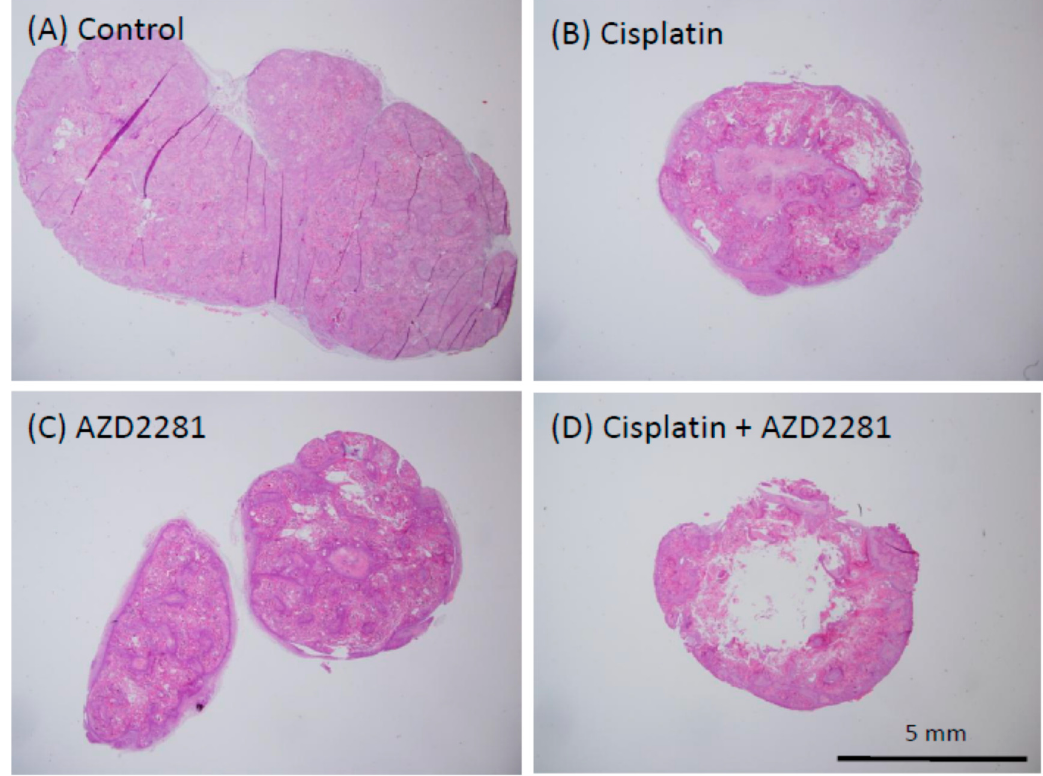
Figure 4. Histopathological analysis of representative xenografted tumors in control ( A ); cisplatin ( B ); AZD2281 ( C ); and combination treatment ( D ) groups. Scale bar, 5 mm.